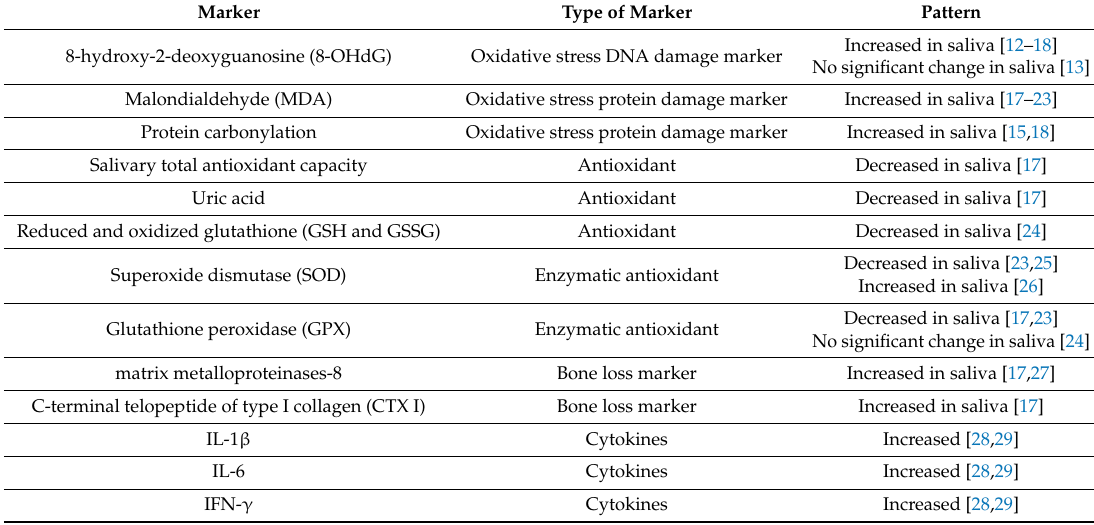
Table 1. Levels of some salivary parameters as possible future periodontitis biomarkers in periodontitis patients compared with